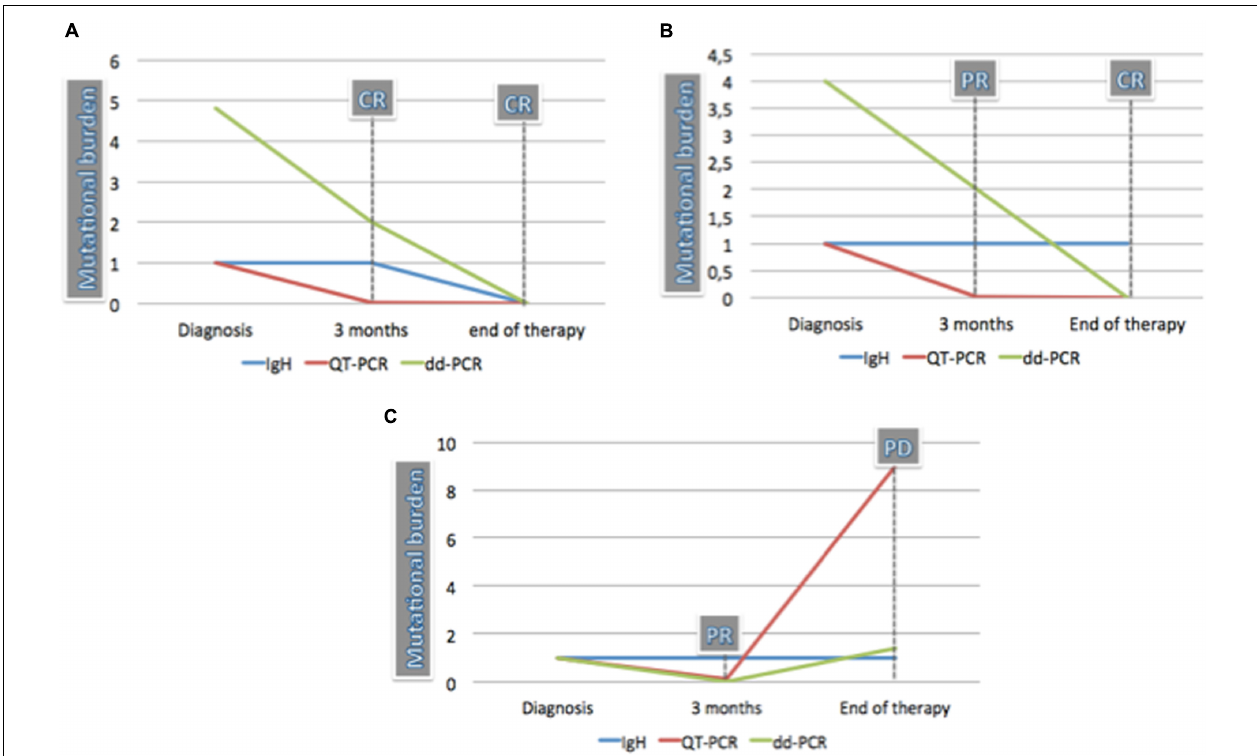
FIGURE 2 | Comparison of MRD in three HCL cases by qualitative PCR for IgH rearrangement, QT-PCR, and dd-PCR. (A) Patient achieved the CR after 3 months and maintained it at the end of treatment. QT-PCR was negative already at the first point when dd-PCR and IgH rearrangement were positive. The mutational burden measured by dd-PCR reduced from 4.87 at diagnosis to 2 at 3 months and became negative at the end of treatment. IgH rearrangement also became negative at the end of therapy. (B) Patient achieved the PR after 3 months and the CR at the end of treatment. The IgH rearrangement remained clonal also when CR was achieved. The mutational burden measured by dd-PCR reduced from 4 at diagnosis to 2 at 3 months when response was partial. At this time point, QT-PCR was already negative. (C) Patient achieved the PR after 3 months but progressed at the end of treatment. IgH was positive both at 3 months and at the end of therapy. QT-PCR mutational burden reduced at the first time point and increased from 0.1 to 9.15 at the sixth month. The mutational burden measured by dd-PCR decreased from 1 at diagnosis to 0.01 at 3 months and increased up to 1.4 at the end of treatment.